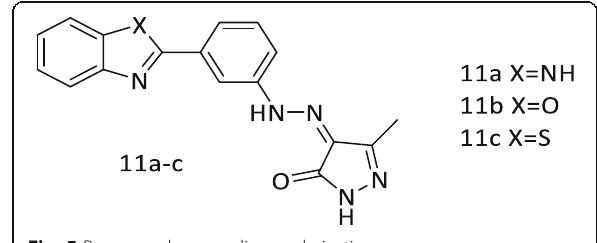
Fig. 5 Benzoxazole-pyrazolinone derivatives